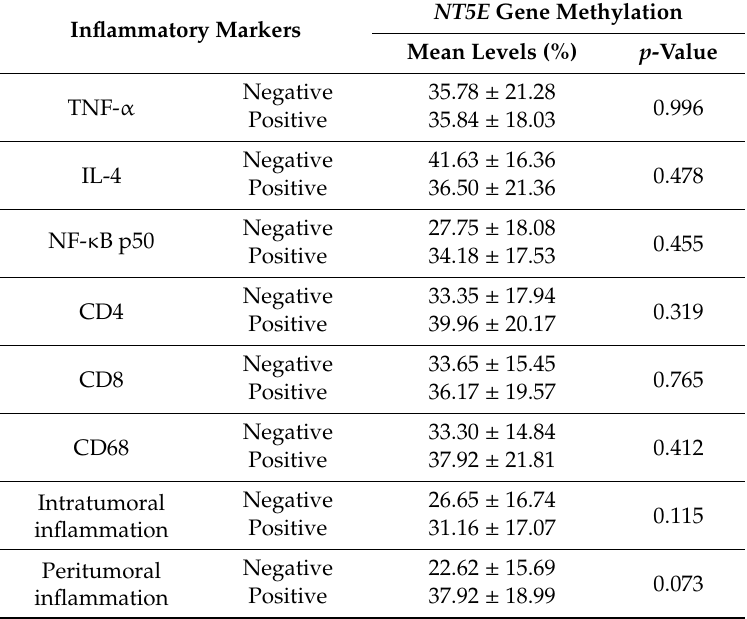
Table 1. Association of methylation level of the NT5E gene with inflammatory markers in tumor tissues. NT5E Gene Inflammatory Markers